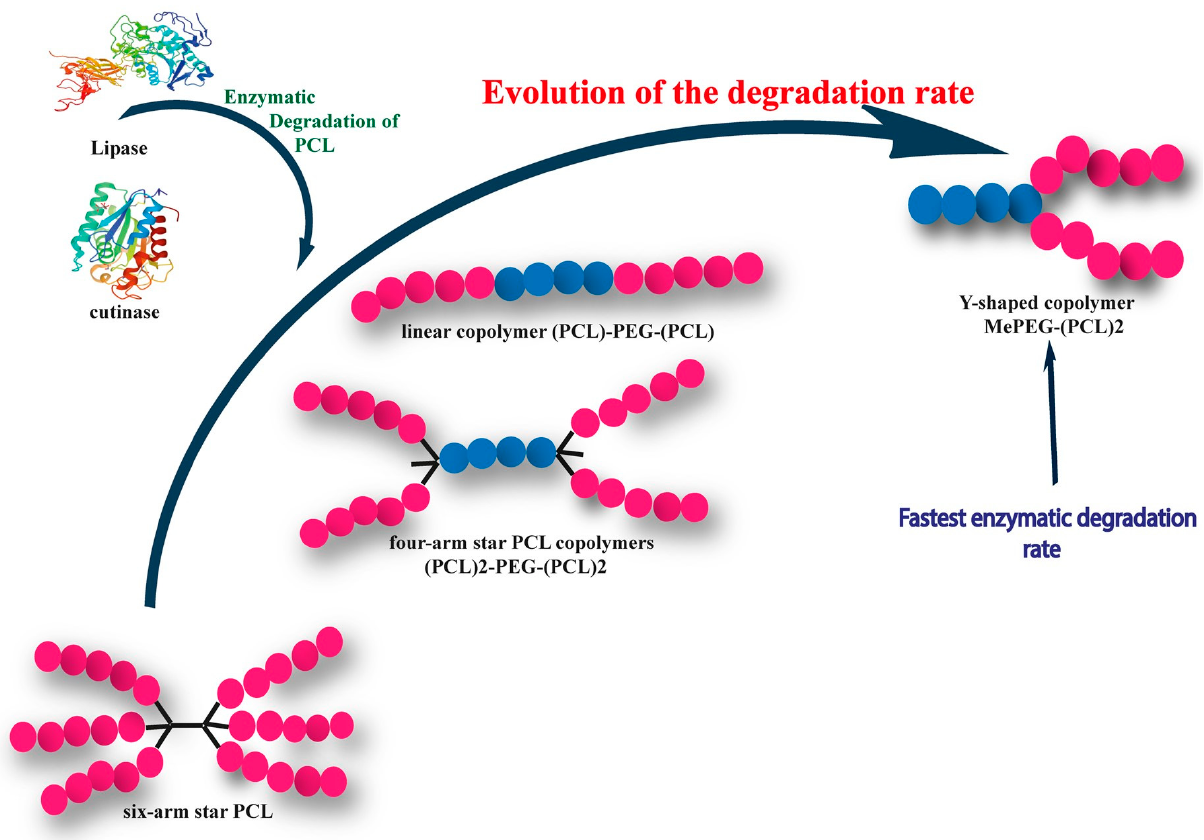
Figure 22. Impact of Architecture of Different PCL-Based Polymers on Degradation Profile.